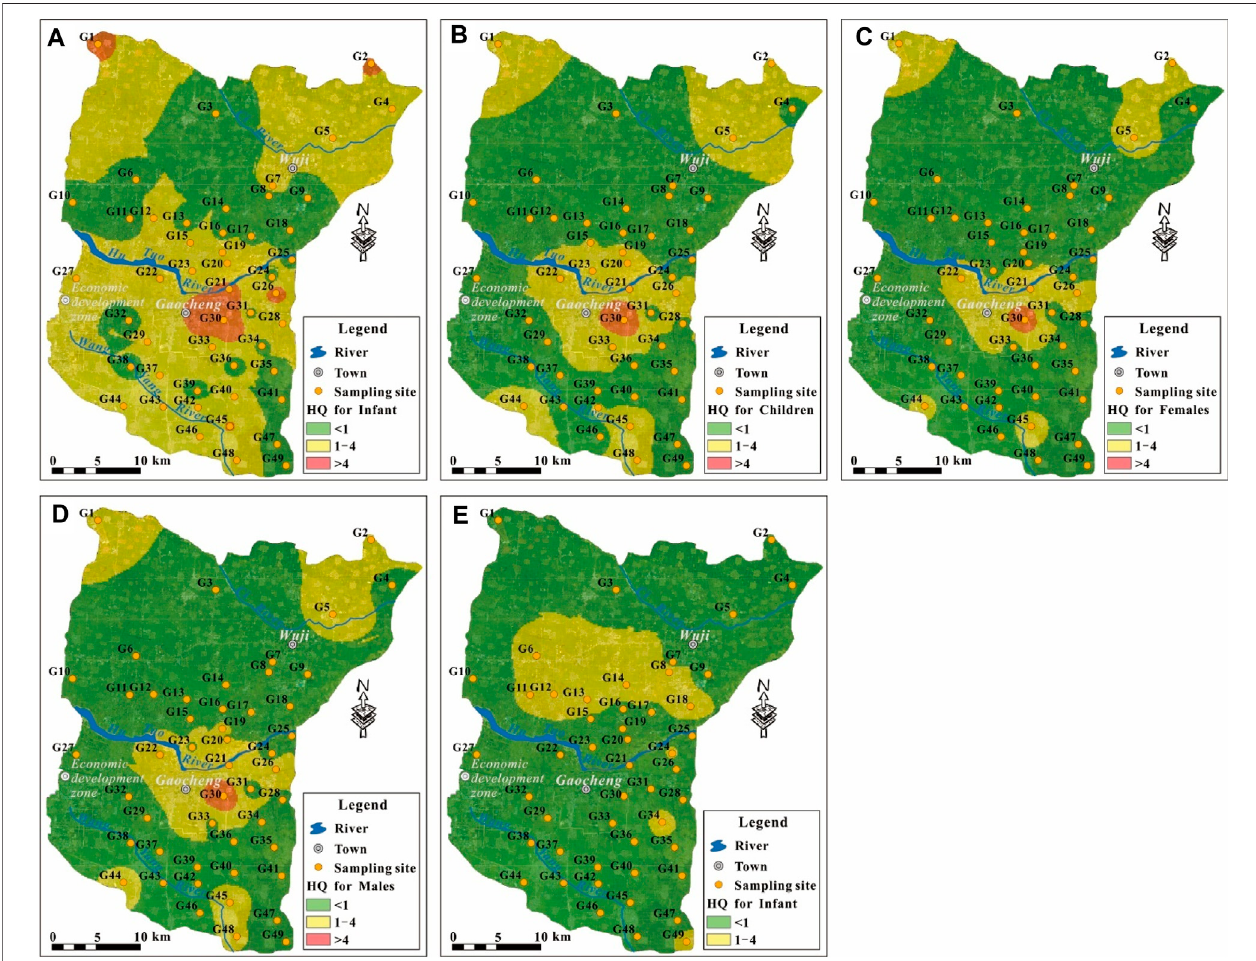
FIGURE 9 | Geospatial distribution of the HQ value posed by NO 3 − for (A) Infants, (B) Children, (C) Adult females, (D) Adult males, and by F − for (E) Infants.